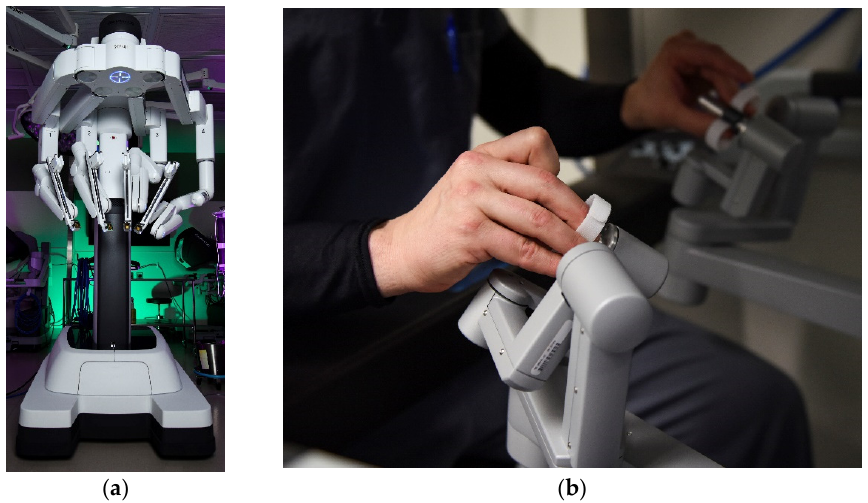
Figure 4. The 99th Surgical Operations Squadron (MSGS) performed their first robotic general surgery using the da Vinci surgery system, April 3, 2019, at the Mike O’Callaghan Military Medical Center. The depicted da Vinci robotic surgery system enables surgeons to perform complex proce- dures with precision and accuracy. ( a ) Shriever Space Force Base da Vinci surgery system [38]. ( b ) General surgeon provides inputs to command the operation of the da Vinci surgery system [38]. tient safety.